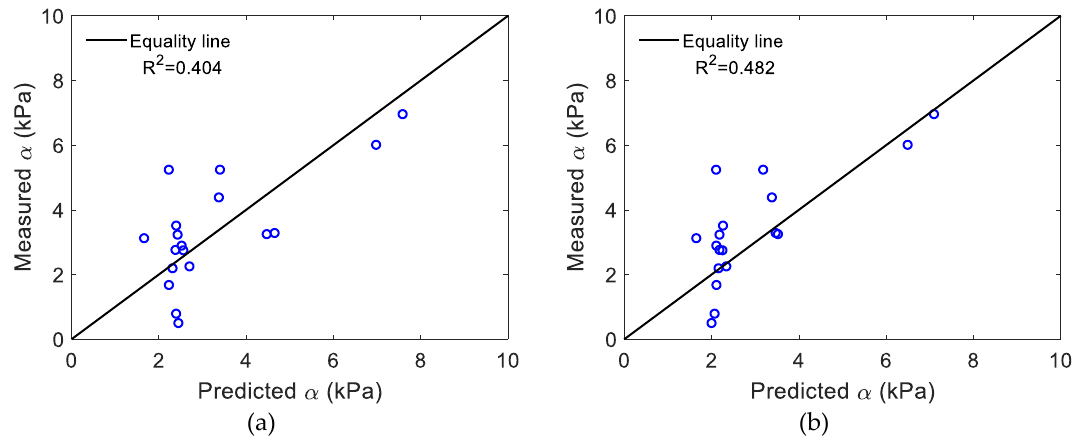
Figure 5. Prediction performance of parameter 𝛼 by the original method and the corrected method. ( a ) original method (Equation (15)); ( b ) corrected method (Equation (19)). Table 1. Soil gradation parameters, porosity values and best fitted water retention curve (WRC) parameters of 𝛼 and 𝑛 for the 18 sandy soils.